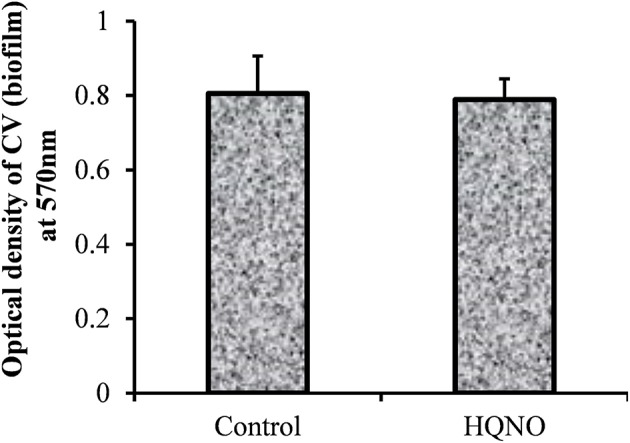
In vitro
biofilm growth of methicillin-resistant Staphylococcus aureus (MRSA) small colony variant. In vitro biofilm growth of MRSA supplemented with HQNO (20 μg/mL) or without HQNO. The biofilm biomass was detected by a crystal violet microtiter plate assay. Error bars represent standard deviation from the mean value.